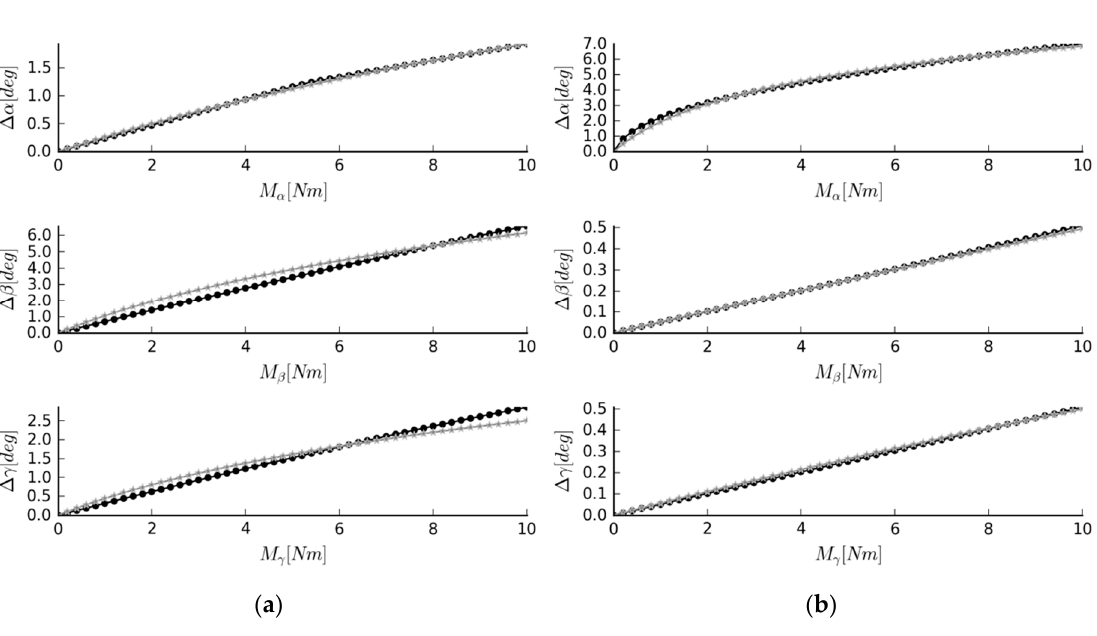
Figure 8. Simulation results for ( a ) Case #2; ( b ) Case #3. Graphs of moment loads acting on the system and angular displacements they cause (black “·” marker—the data obtained from the mechanism, grey “*” marker—the reference data); α —the flexion, β —the lateral bending angle, γ —the axial rotation angle.